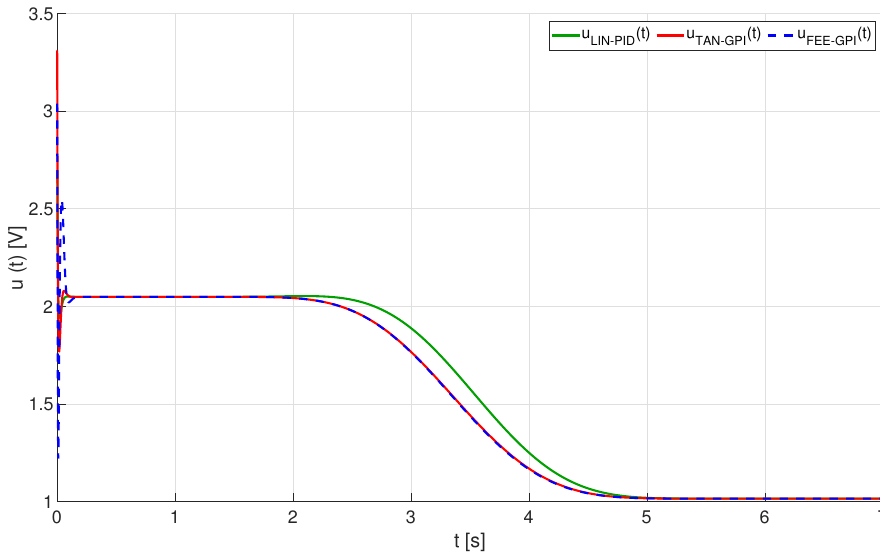
Figure 5. Control input of the magnetic levitation system, u ( t )[ V ] , nominal case (Test 1).